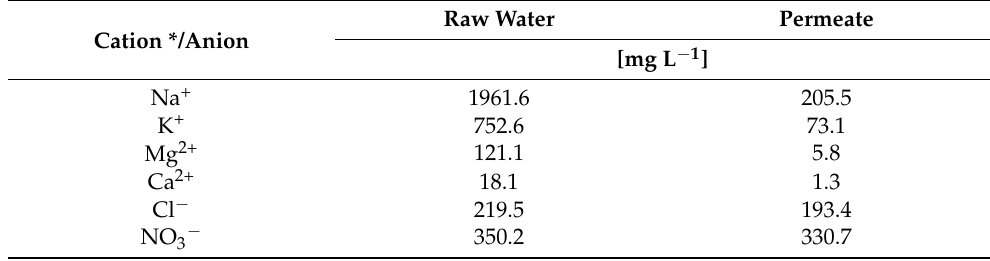
Table 2. Chemical composition of simulated raw water and permeate from the CSS-supported